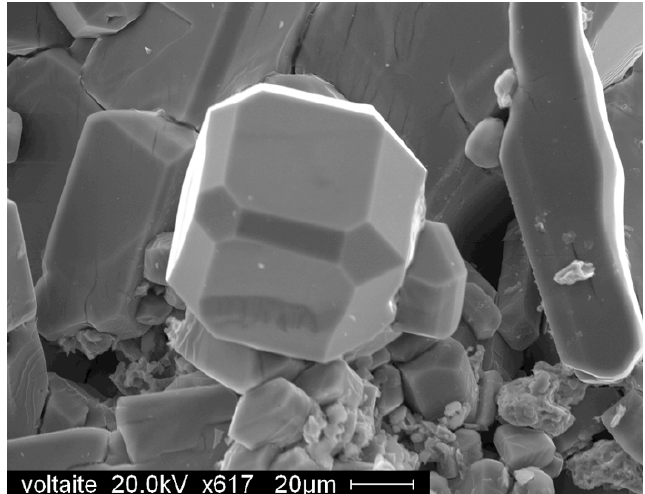
Figure 24. Voltaite from the Fornovolasco mine, as cubic crystals with minor {110} and {111} faces.